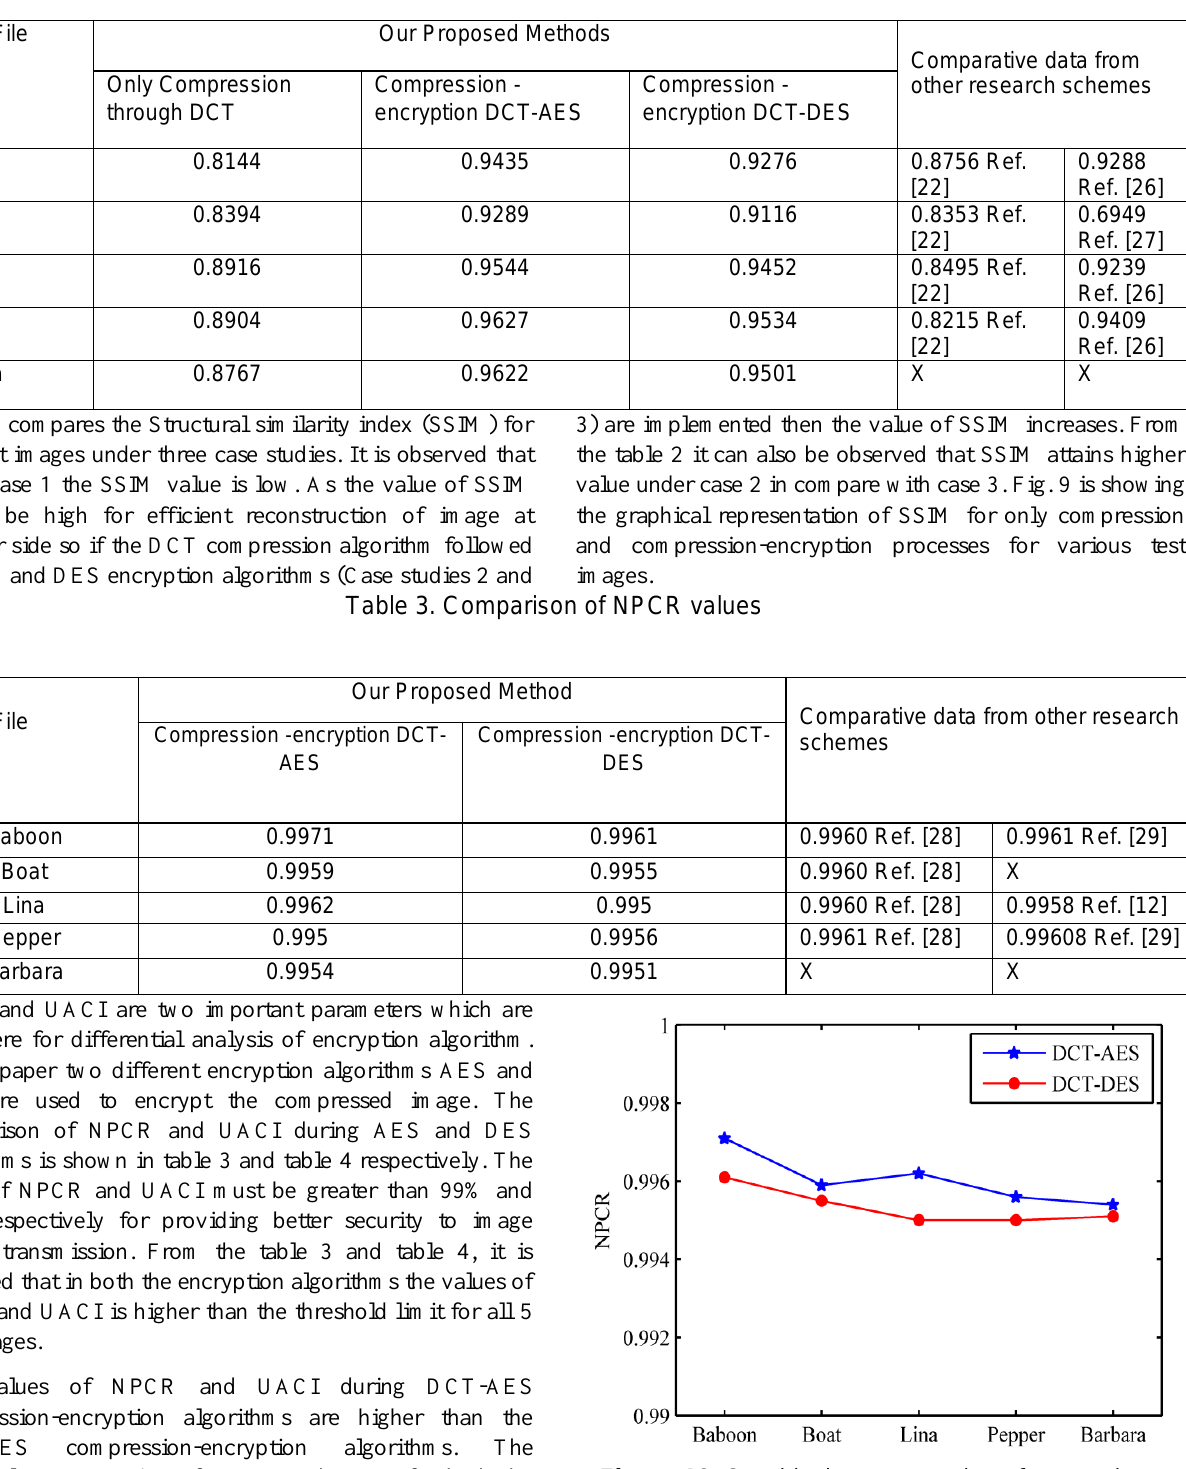
Figure 10 . Graphical representation of